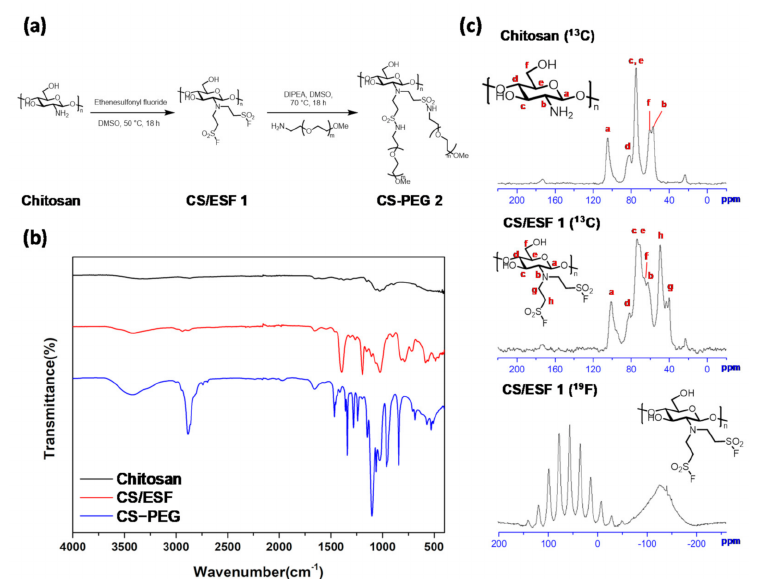
Figure 1. Synthesis and characterization of chitosan-PEG. ( a ) Synthetic route of CS/ESF 1 and CS/PEG 2. ( b ) FT-IR spectra of chitosan (black), CS/ESF 1 (red) and CS/PEG 2 (blue). ( c ) Solid-state NMR spectra of chitosan and CS/ESF